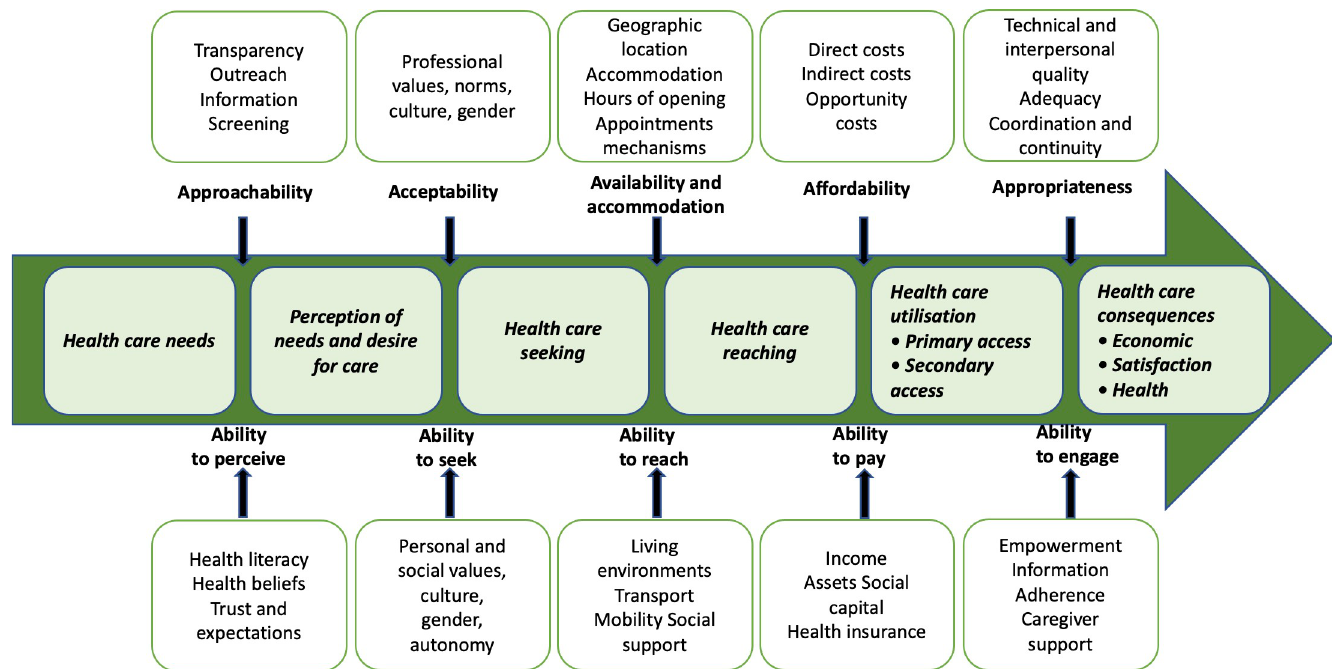
Fig 1. A conceptual framework of access to health care. Levesque proposed a model of the determinants of access to health care